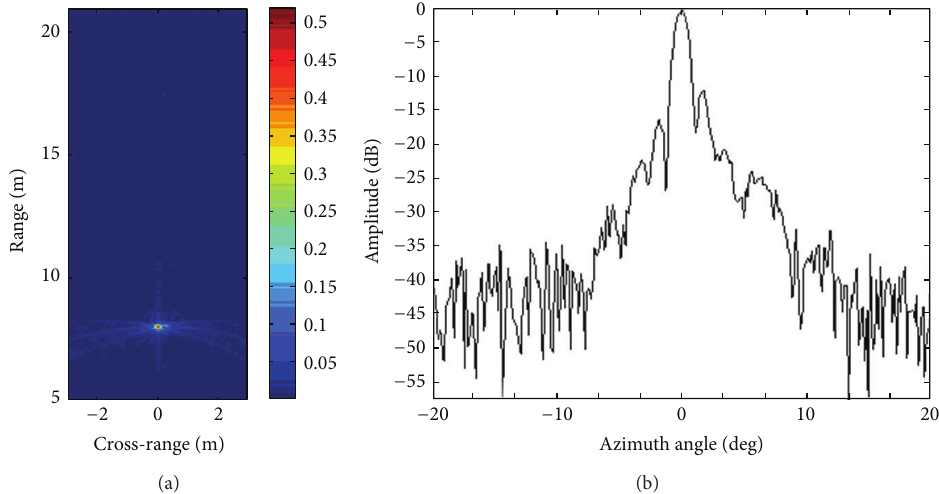
Figure 6: Image of metal trihedral corner reflector. (a) Imaging result. (b) Peak amplitude pattern in azimuth angle.